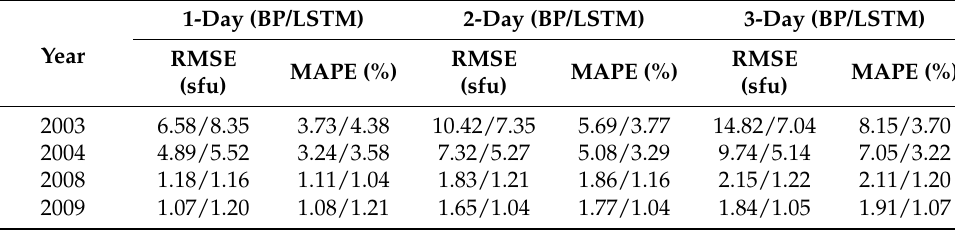
Table 3. Comparison of the prediction performance between LSTM and BP.